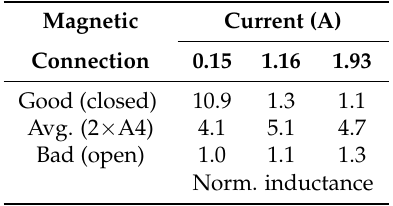
Table 4. Normalized inductance for different